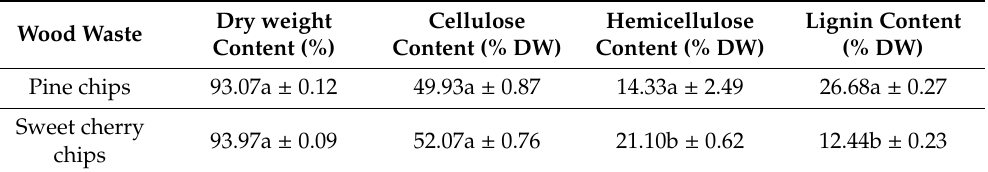
Table 5. Characteristics of wood waste used in this